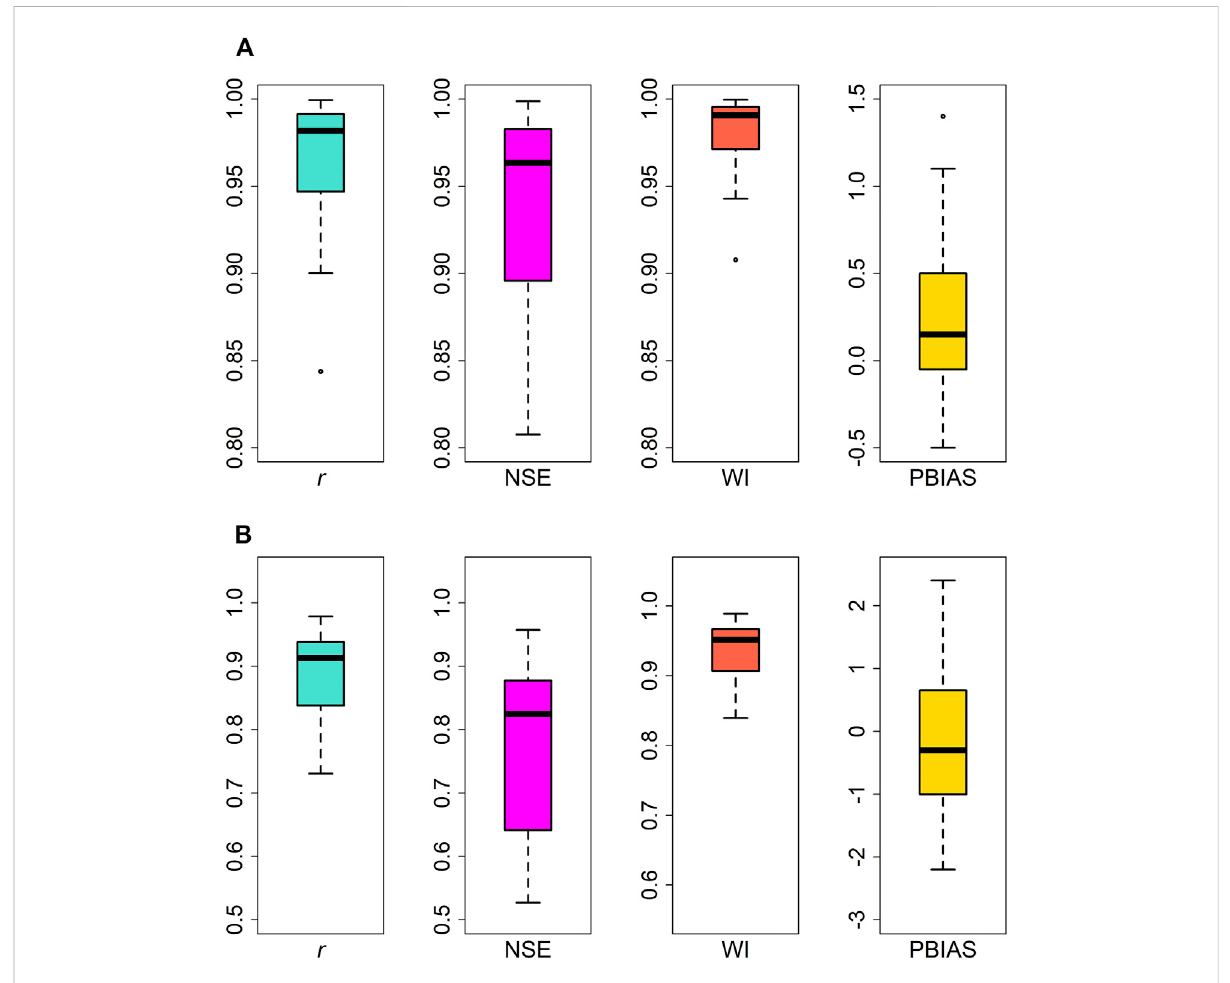
FIGURE 5 Boxplots for (A) the training phase and (B) the testing